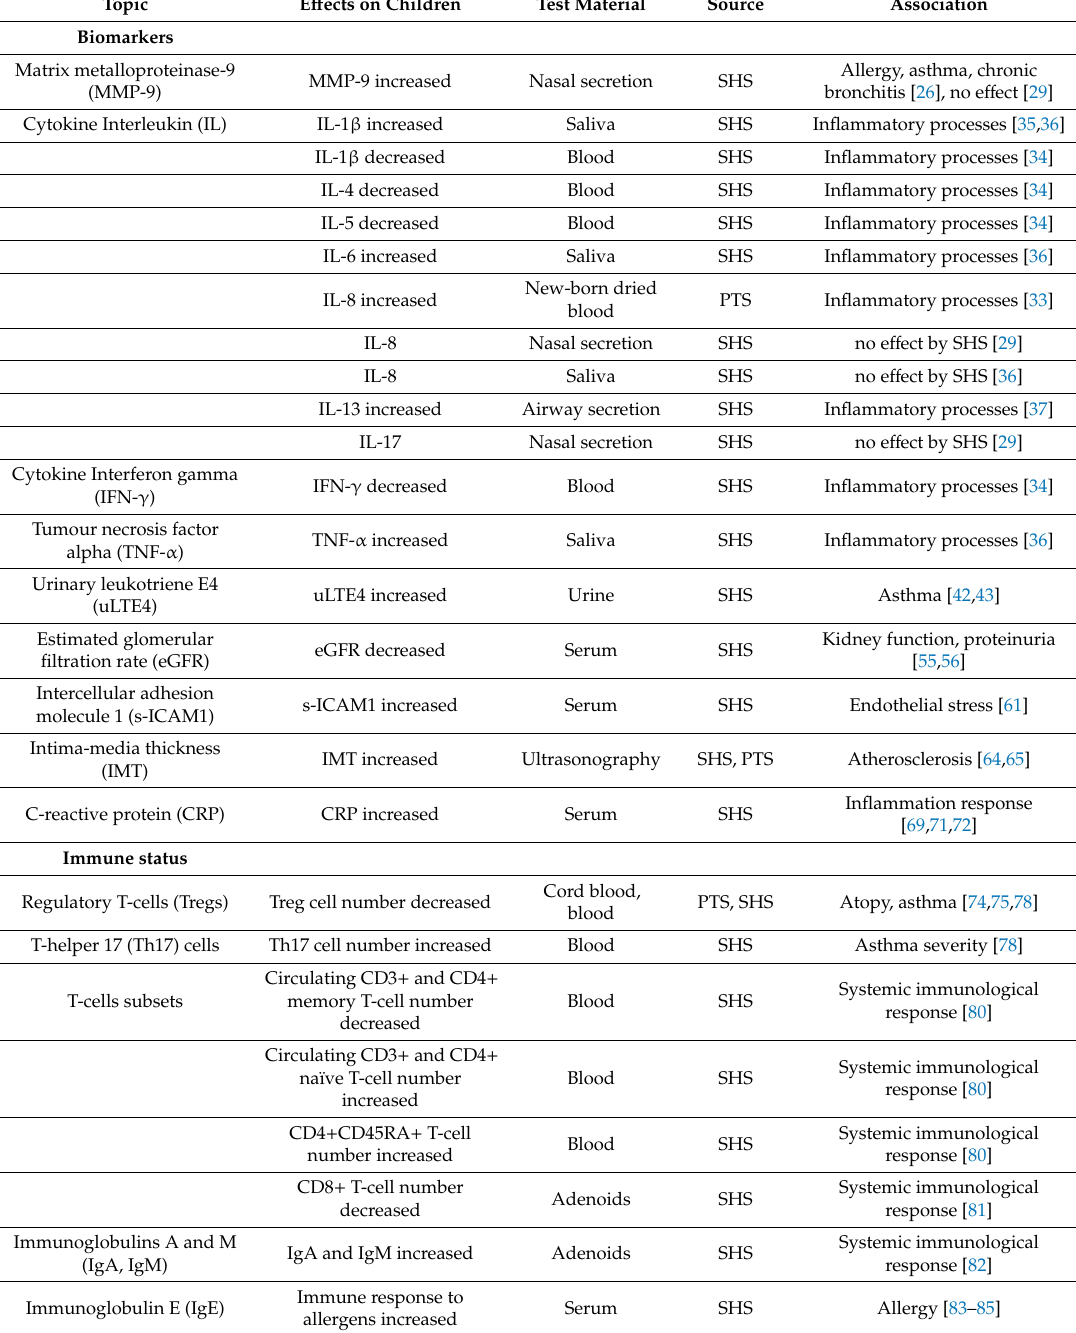
Table 1. Summary of changes in children induced by second-hand smoke (SHS) and prenatal tobacco smoke (PTS)